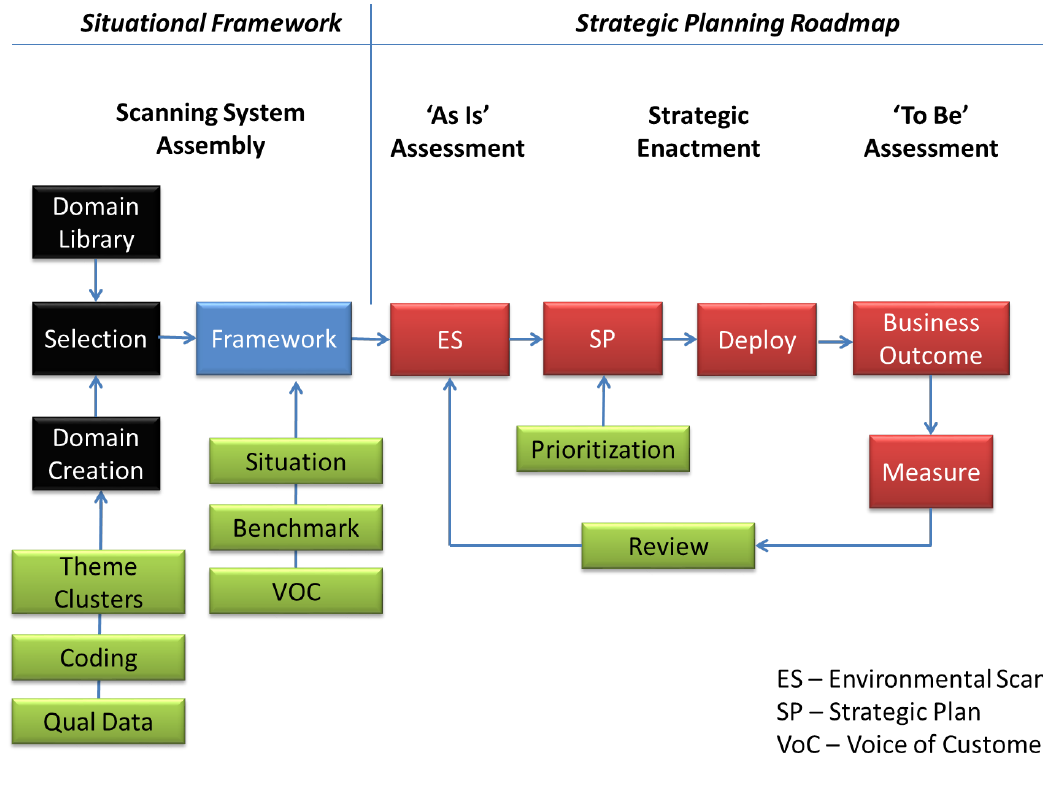
Figure 6. Strategic planning roadmap.